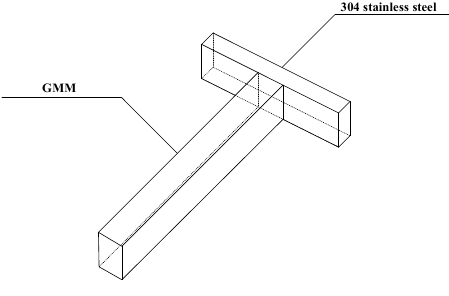
Figure 2. The T-shape structure composed of GMM and 304 stainless steel. The bracket of the T-shape structure is GMM, which is called Terfenol-D rod. The beam of the T-shape structure is 304 stainless steel.